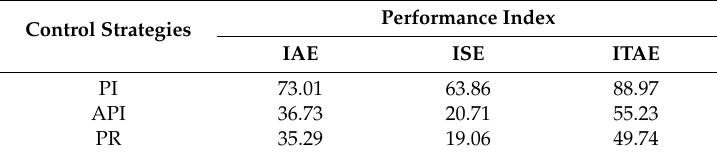
Table 10. Performance evaluation of the designed control strategies for I q .